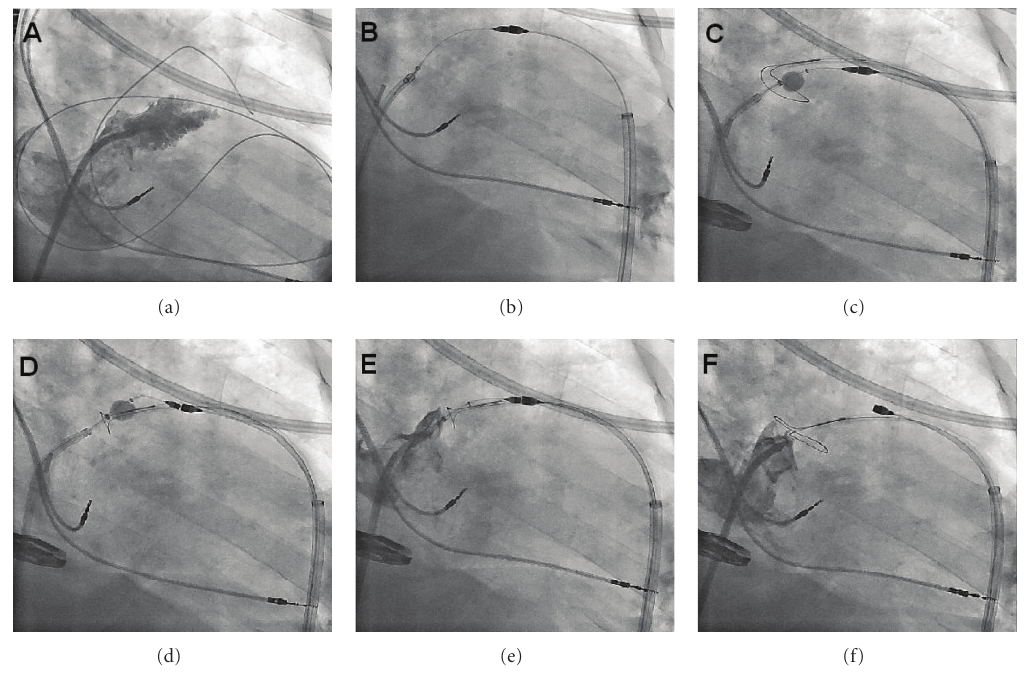
Figure 8: Fluoroscopic sequence of the LARIAT procedure. (a) After transseptal and pericardial access, baseline left atrial angiography identifies the left atrial appendage. (b) Magnet-tipped endocardial and epicardial guidewires make contact across the wall of the left atrial appendage. (c) The balloon catheter is inflated just within the ostium of the left atrial appendage, guiding the placement of the epicardial snare. (d) The snare is tightened at the base of the left atrial appendage. (e) The balloon catheter is pulled back and left atrial angiography confirms occlusion of the left atrial appendage. (f) The suture is cinched down permanently, the snare is retracted, and a final left atrial angiogram reconfirms complete occlusion of the left atrial